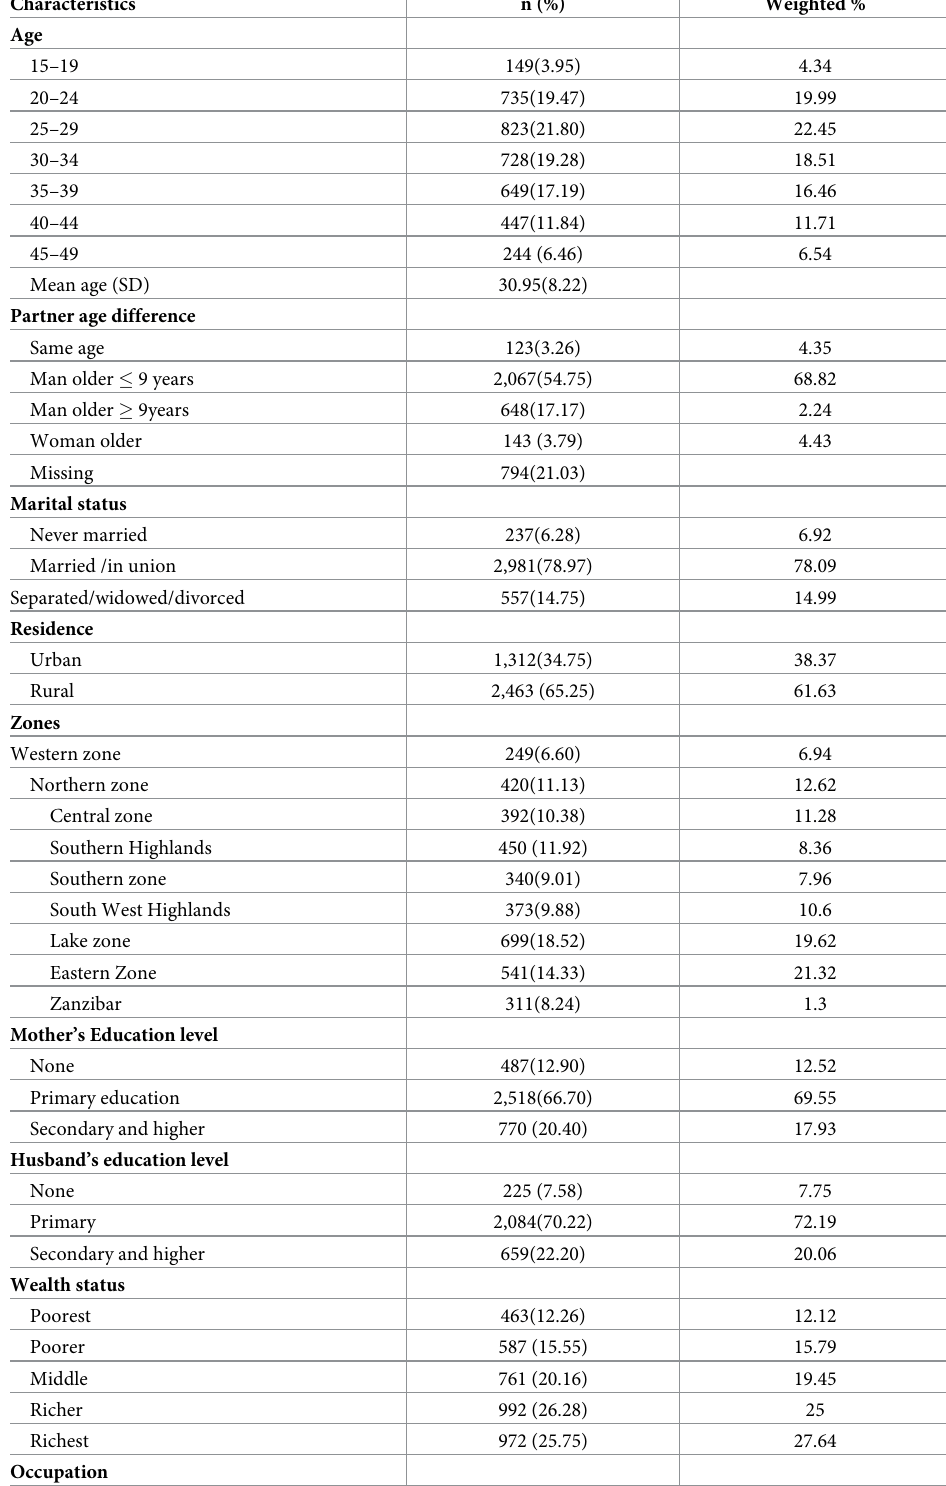
Table 1. Socio-demographic characteristics of the study participant (N =